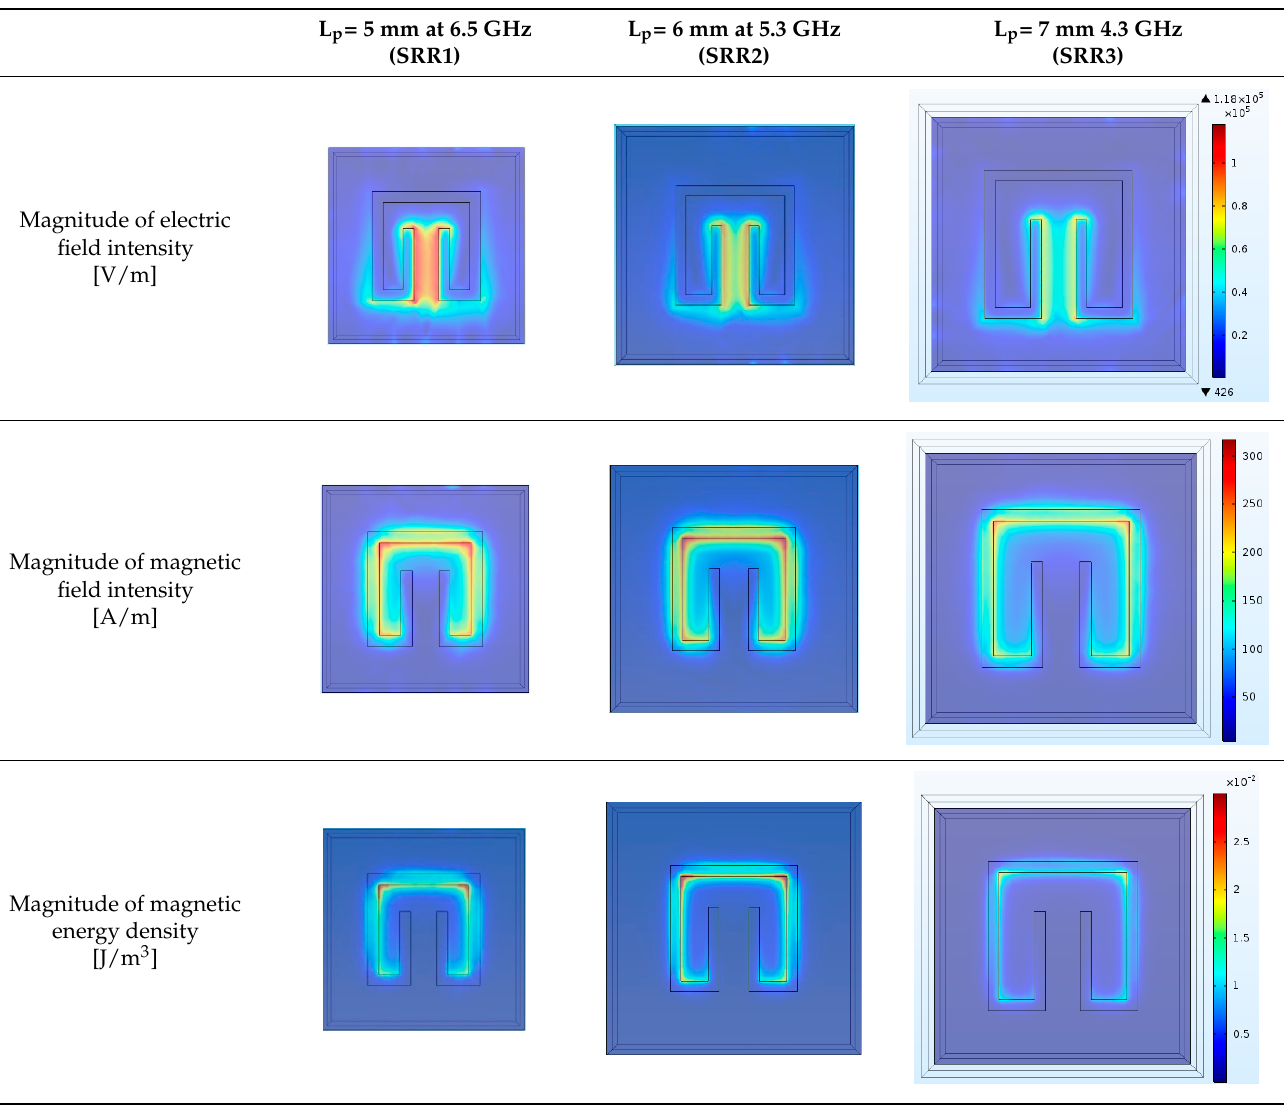
Table 1. Numerical predictions of electromagnetic fields for the test cases.